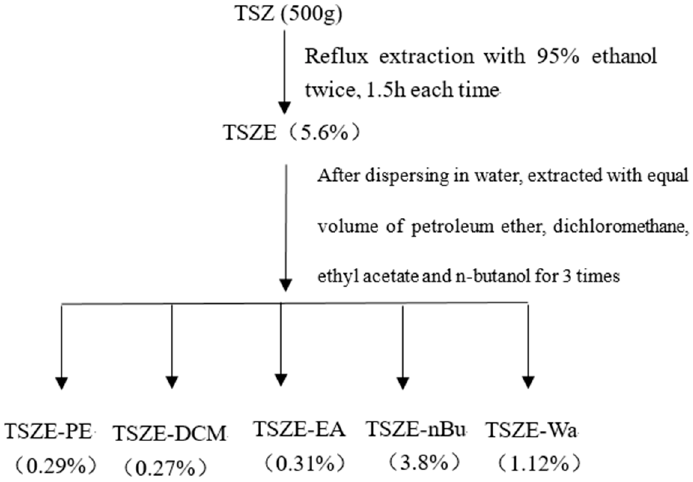
Figure 7. Isolation process of each part of Cuscuta chinensis .